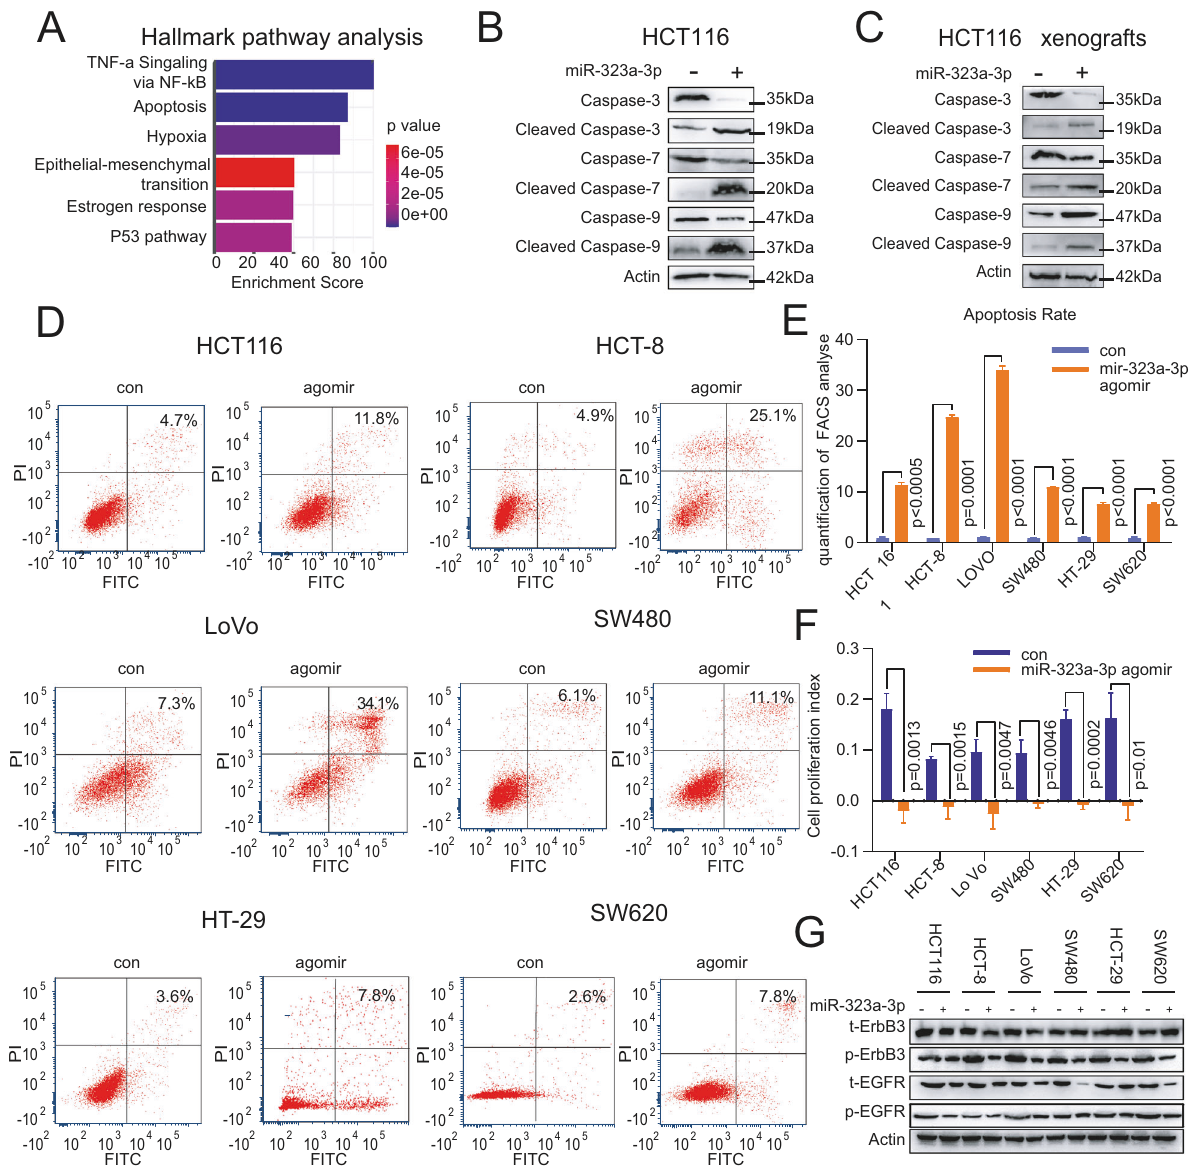
Fig. 3 MiR-323a-3p inhibits tumor growth by promoting apoptosis. A MiR-323a-3p promoted apoptosis (the second process, hierarchical clustering analysis in miR-323a-3p over-expressing HCT-116 cells). B MiR-323a-3p activated apoptotic markers (Caspase 3/7/9, in HCT 116 cells). C MiR-323a-3p activated apoptotic markers (Caspase 3/7/9), in miR-323a-3p agomiR treated HCT116 xenograft tissues. D MiR-323a-3p promoted apoptosis in CRC cells (miR-323a-3p agomiR treated HCT-116, SW620, LoVo, HCT-8, HT-29 and SW480) for 72 h, by annexin V/PI fl ow cytometry analysis. E The apoptosis rate statistics of miR-323a-3p agomiR treated CRC cells by annexin V/PI fl ow cytometry analysis. F miR- 323a-3p agomiR inhibited CRC cell proliferation (miR-323a-3p agomiR treated HCT-116, SW620, LoVo, HCT-8, HT-29 and SW480 for 72 h, by xCELLigence RTCA DP assay). G miR-323a-3p agomiR inhibited total and phosphorylated EGFR and ErbB3 protein levels (miR-323a-3p agomiR treated HCT-116, SW620, LoVo, HCT-8, HT-29 and SW480 for 72 h). miR-323a-3p over-expression cells. The results showed that the levels of apoptotic markers were activated in HCT116 cells and subcutaneous tumors in response to over-expression of miR-323a- 3p (Fig. 3B, C). Similar results were obtained in HCT-8 cells (Supplementary Figure 3B, C). To investigate the apoptotic function of miR-323a-3p in CRC, we selected 6 CRC cell lines in CRC treated with miR-323a-3p agomiR (HCT116, LoVo, SW480, SW620, HCT-8 and HT-29) for fl ow cytometry analysis, and the results showed that miR-323a-3p promoted apoptosis in all 6 types of cells (Fig. 3D, E and Supplementary Figure 8). A similar effect was obtained on the proliferation of the 6 types of cells by RTCA cell